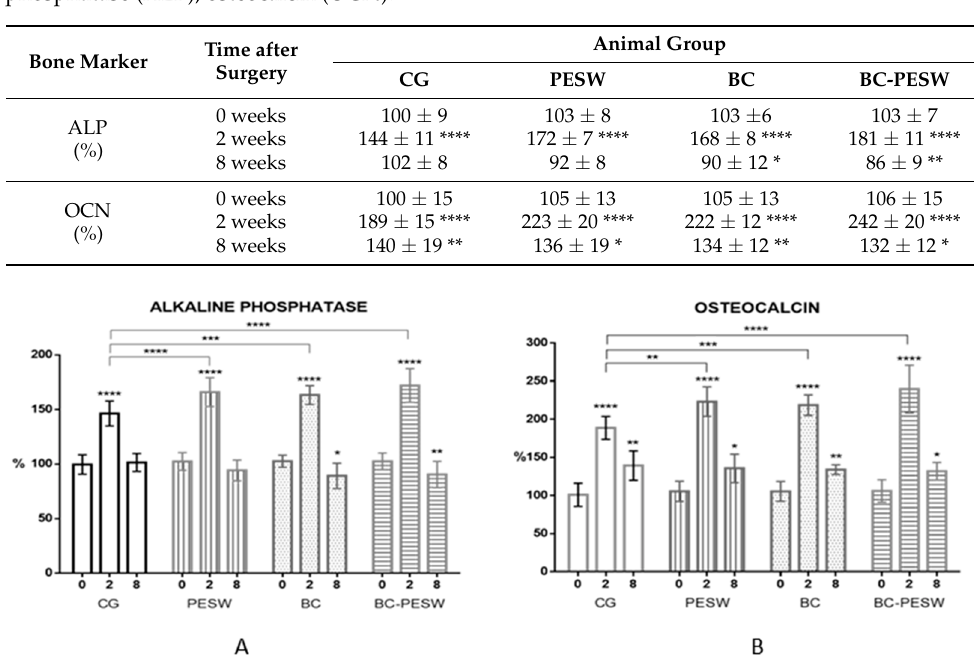
Table 2. Quantitative results of the implant osseointegration, as assessed using micro-CT; * p < 0.05 vs. CG; & p < 0.05 vs PESW. The bone volume per total volume (BV/TV), the mean trabecular number (Tb.N), the mean trabecular thickness (Tb.Th), the mean trabecular separation (Tb.Sp) and bone-to- implant contact (BIC) are given for the four animal